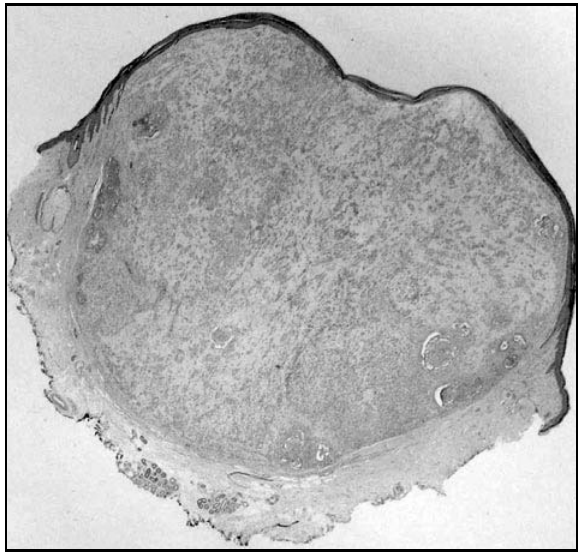
Figura 1 – Neoplasia dérmica constituída pelos elementos epitelial e mesenquimal (H&E, 20x)